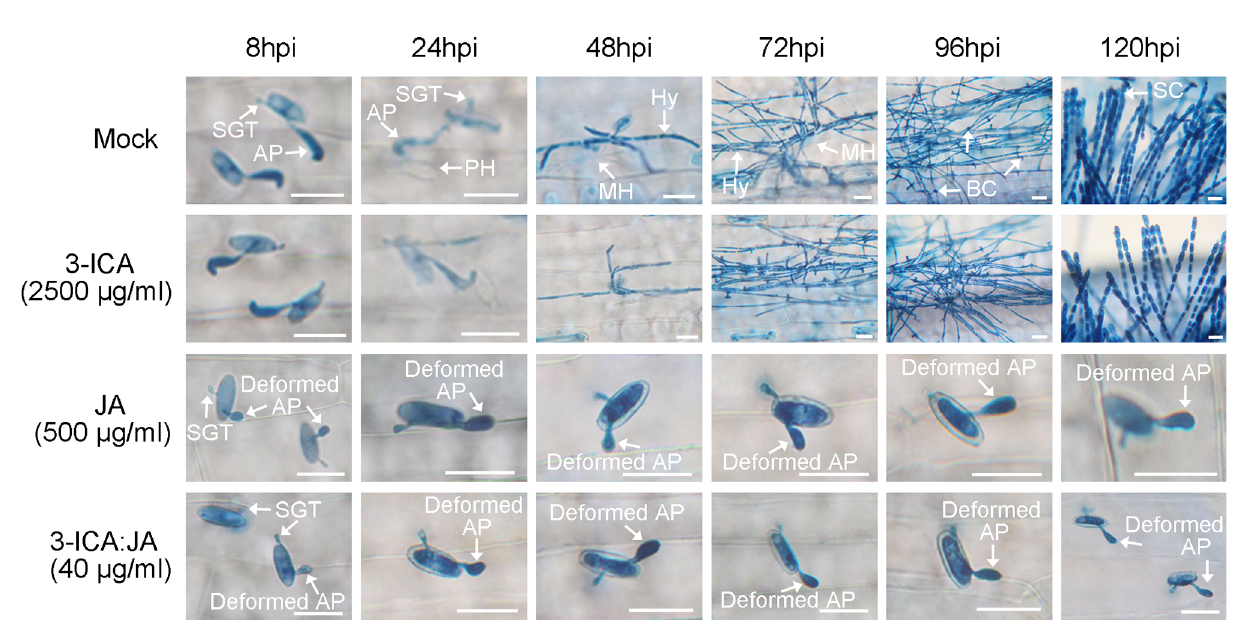
FIGURE 3 | The development of B graminis on wheat leaves at different time courses in 3-ICA, JA, and their combination treatment. Mock, untreated control; 3-ICA, indole-3-carboxylic acid at 2,500 m g/ml; JA, jasmonic acid at 500 m g/ml; 3-ICA:JA, the 2:8 combination of indole-3-carboxylic acid and jasmonic acid at 40 m g/ml. Sampling time was 8, 24, 48, 72, 96, and 120 hpi, respectively. SGT, sticky germ tube; AP, appressorium; PH, primary haustorium; MH, mature haustorium; Hy, hypha; BC, base of conidiophores; SC, spore chain. The deformed appressoria failed to penetrate the host cells. Scale bar = 20 m m.